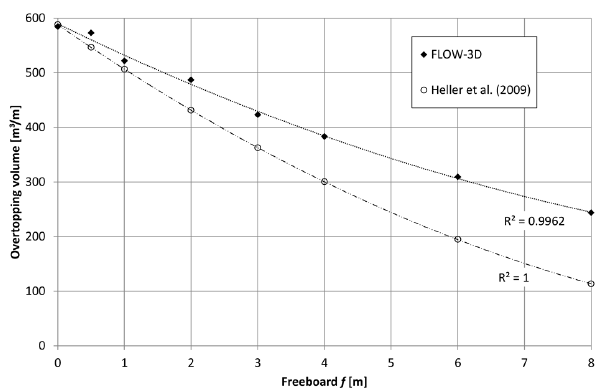
Figure 7. Overtopping volume V depending on the freeboard f including trendlines with a fixed still water depth h =